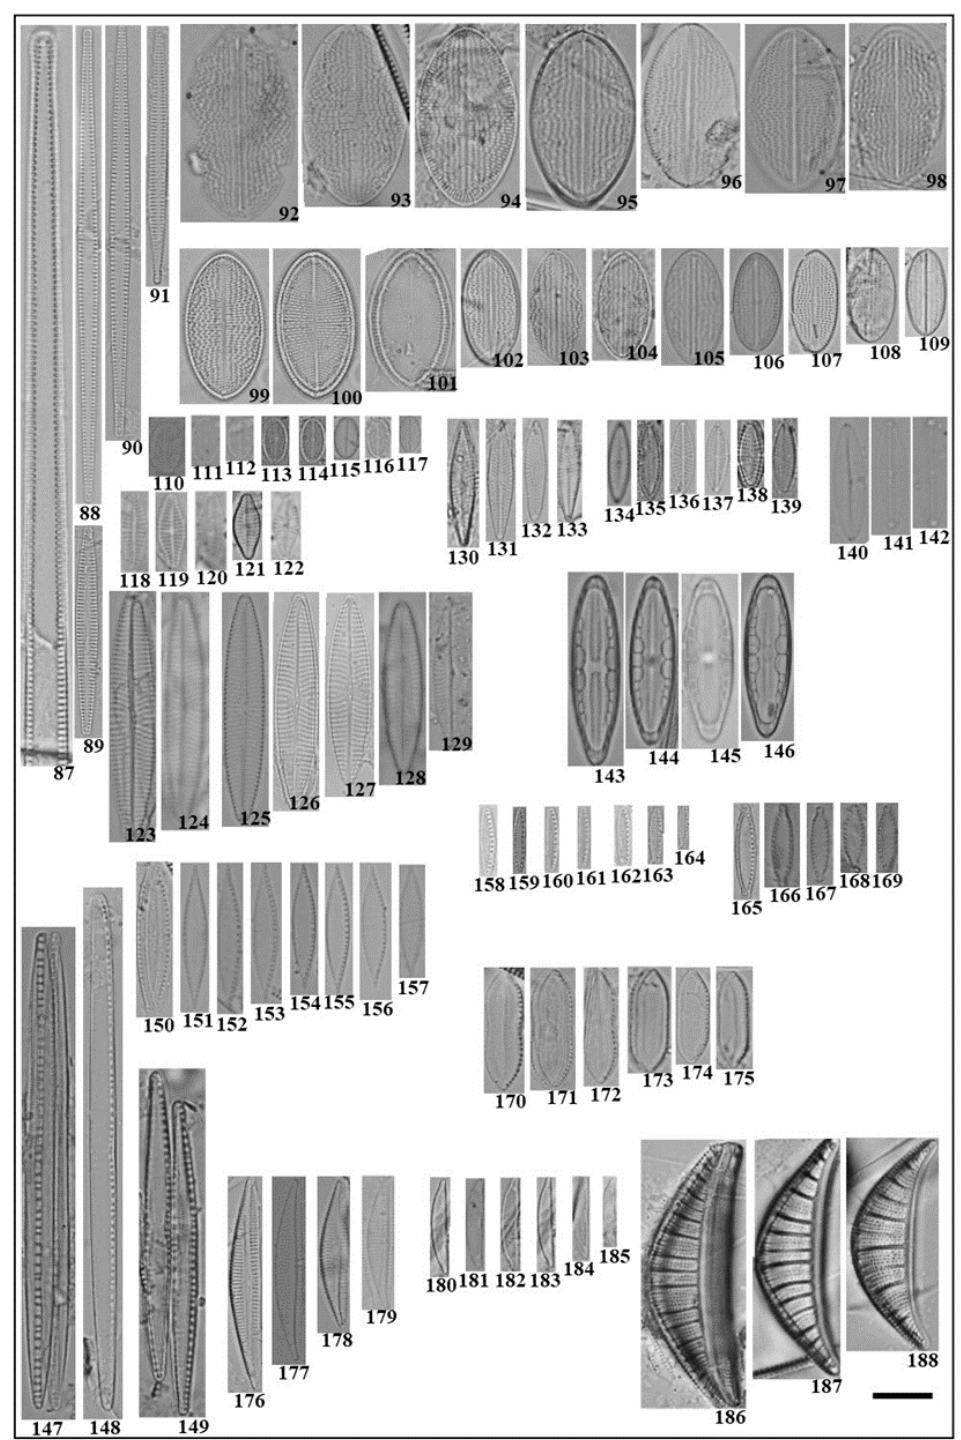
Figure 4. Tabularia tabulata (87 – 91); Cocconeis placentula (92 – 109); Fistulifera saprophila (110 – 117); Planothidium sp. (118 – 122); Navicula cryptotenella (123 – 129); Navicula cruxmeridionalis (130 – 133); Navicula sp.3 (134 – 139); Navicula sp.5 (140 – 142); Mastogloia pumila (143 – 146); Bacillaria paxillifera (147); Nitzschia filiformis (148); N. subcohaerens var. scotica (149); N. eutinensis (150 – 157); N. frustulum (158 – 164); N. microcephala (165 – 169); Tryblionella persuadens (170 – 175); Seminavis strigosa (176 – 179); Catenula adhaerens (180 – 185); Rhopalodia rumrichiae (186 – 188). Scale bar = 10 μ m.